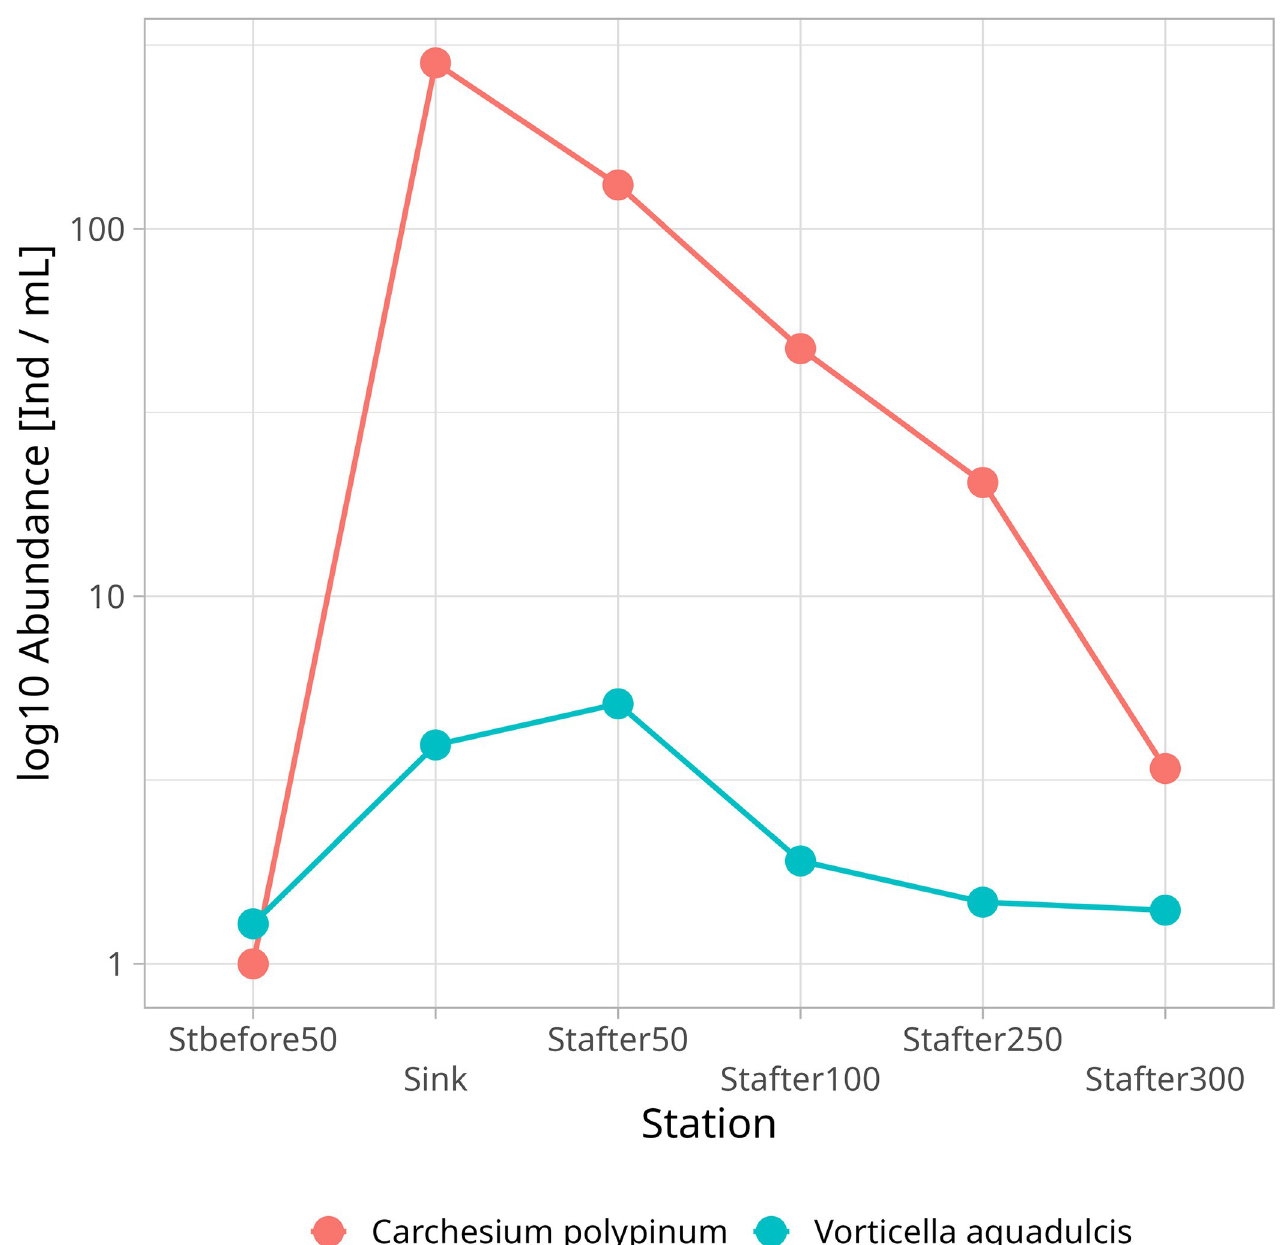
Fig 5. Changes in the abundance of Carchesium polypinum and Vorticella aquadulcis by stations in an environmental gradient based on data for the entire study